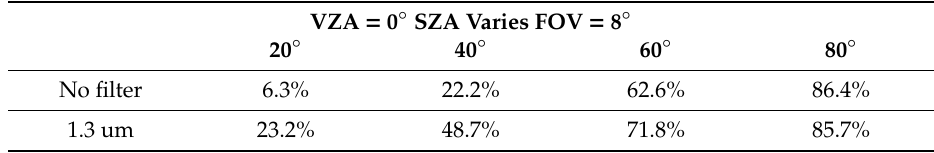
Table 8. Chance of more than 3 stars measured in the FOV with di ff erent detection bands under di ff erent observation conditions at 20